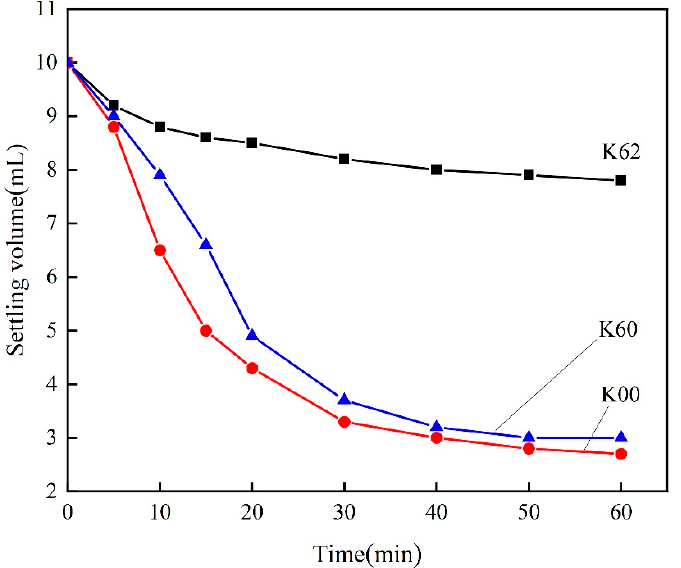
Figure 4. Variation of the sedimentation volume of kaolin in liquid para ffi n.